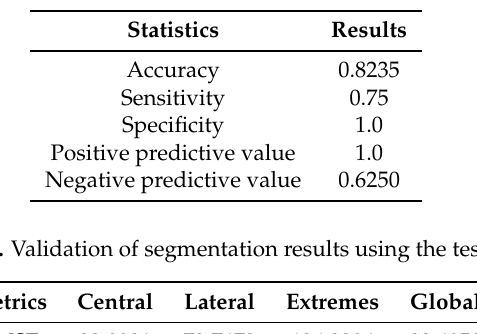
Table 2. Validation of the classification results using the test set.